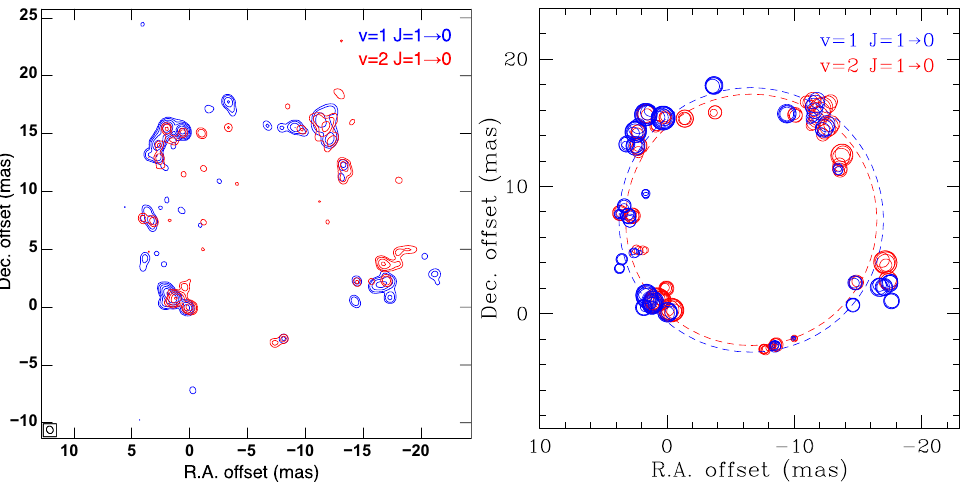
Figure 5. ( Left ) Spatial distribution of the SiO masers around WX Psc on 2012 April 1. Blue and red colors represent the v = 1 and 2, J = 1–0 SiO maser. ( Right ) Superposed map of SiO masers for v = 1 and 2, J = 1–0 in blue and red colors, respectively. Dashed circles show the average size of the ring-like structure for each SiO maser spot. Adapted from the work in [102] with permission from